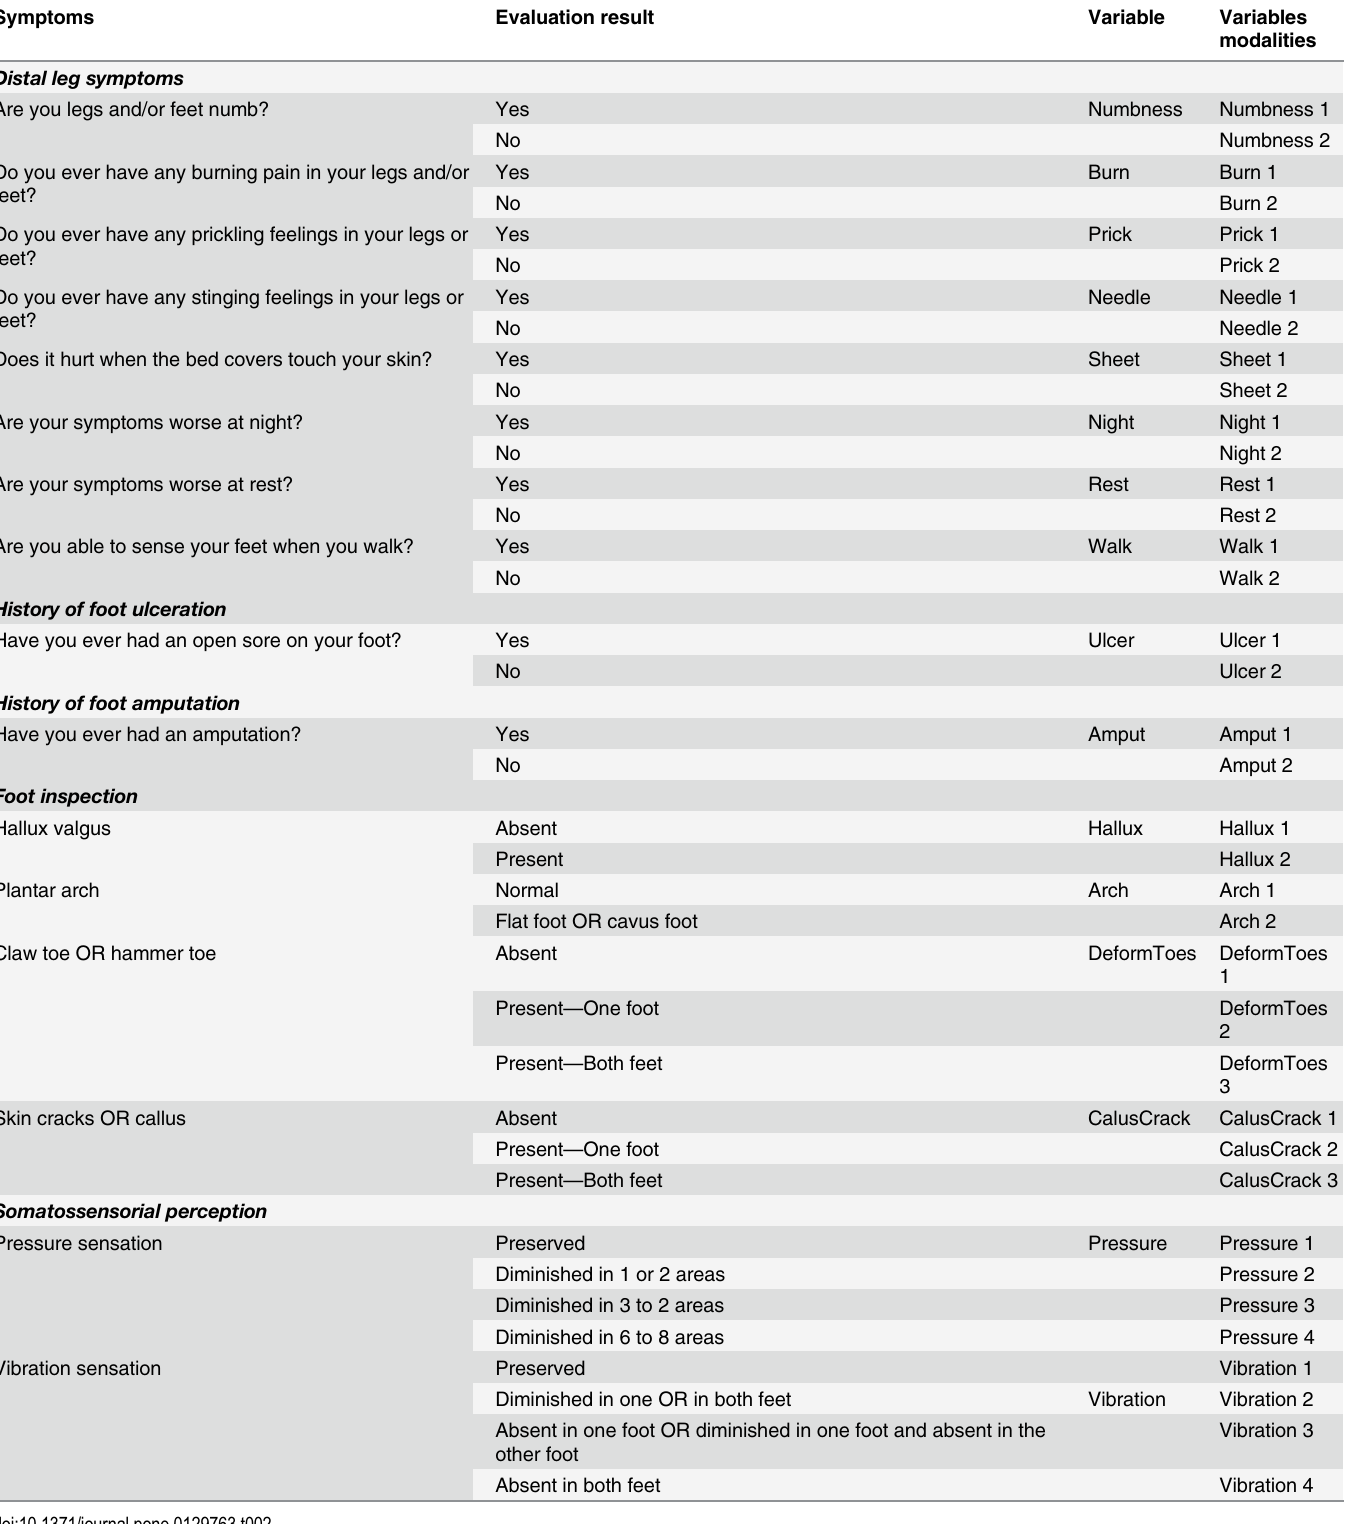
Table 2. Symptoms and signs assessment, qualitative DPN-related variables for the study and variables